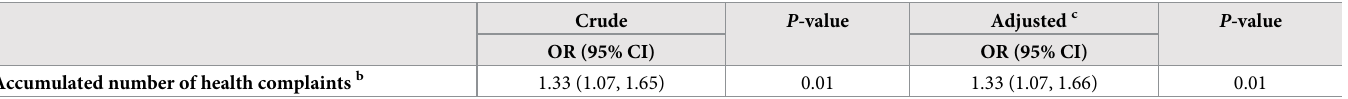
Table 3. Logistic regression analyses of the association between the number of health complaints at baseline and persistent musculoskeletal pain a at 2-year follow-